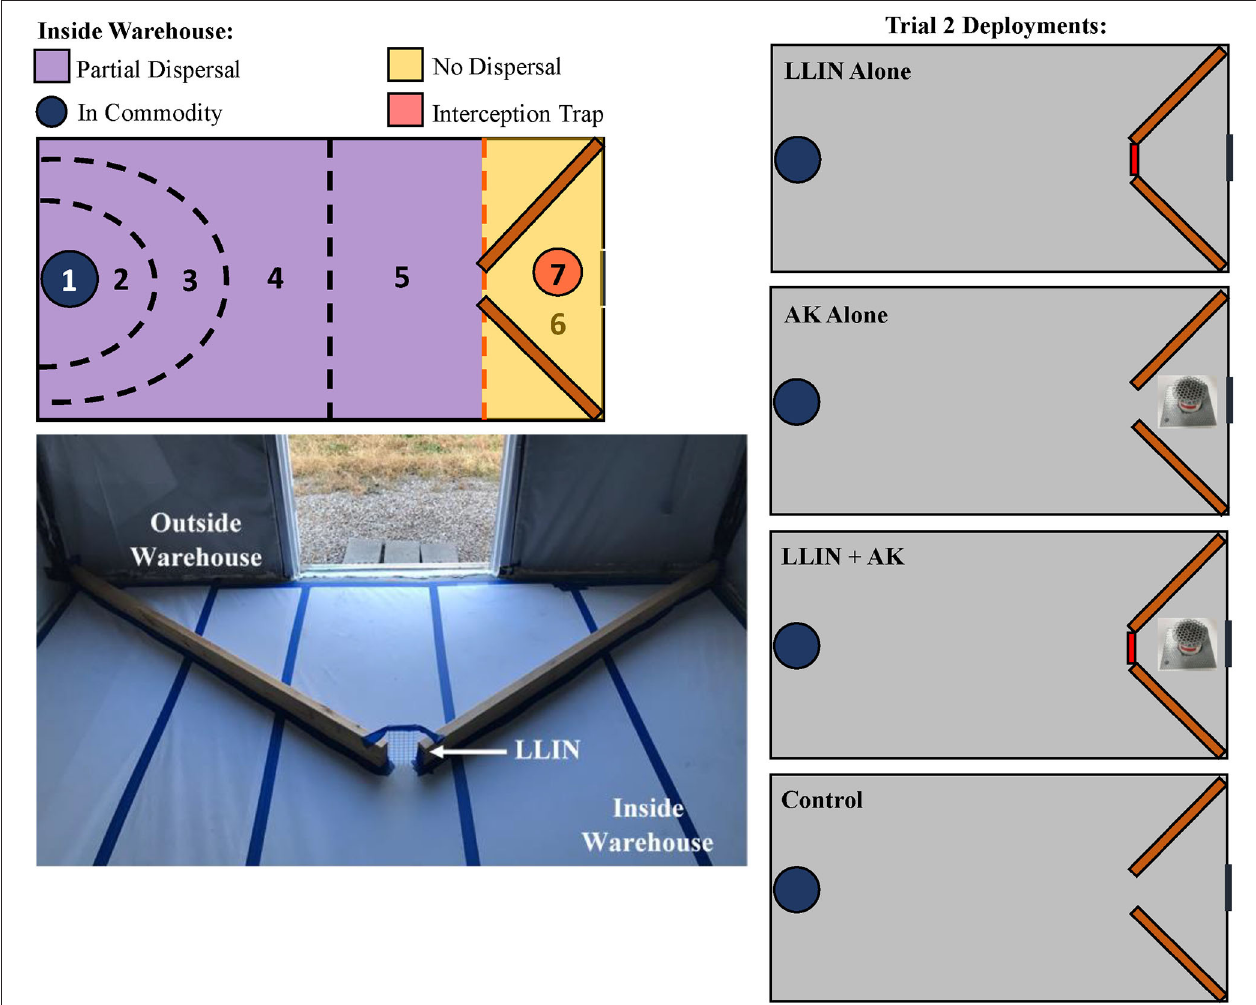
FIGURE 3 | Schematic of the designated recapture zones inside the pilot-scale warehouses where insects were released in Trial 2 (the combined AK and LLIN Assay), including a Zone 7 for the interception trap deployment (top, left). Insects were released “outside” the warehouse in the two corners of Zone 6, given 72-h to travel “inside” the warehouse through Zones 2–5, and collected in the commodity Zone 1 Two wooden planks acted as a funnel for the insects to enter inside the warehouse; the gap (see arrow) between the two planks was the point of entrance with control netting (without insecticide) or LLIN bridging the gap between the two planks (bottom, left). Treatments are schematically represented on the right, showing the three LLIN and interception trap deployment methods for Trial 2, including a control treatment with no LLIN or interception trap. The red lines indicate deployment of